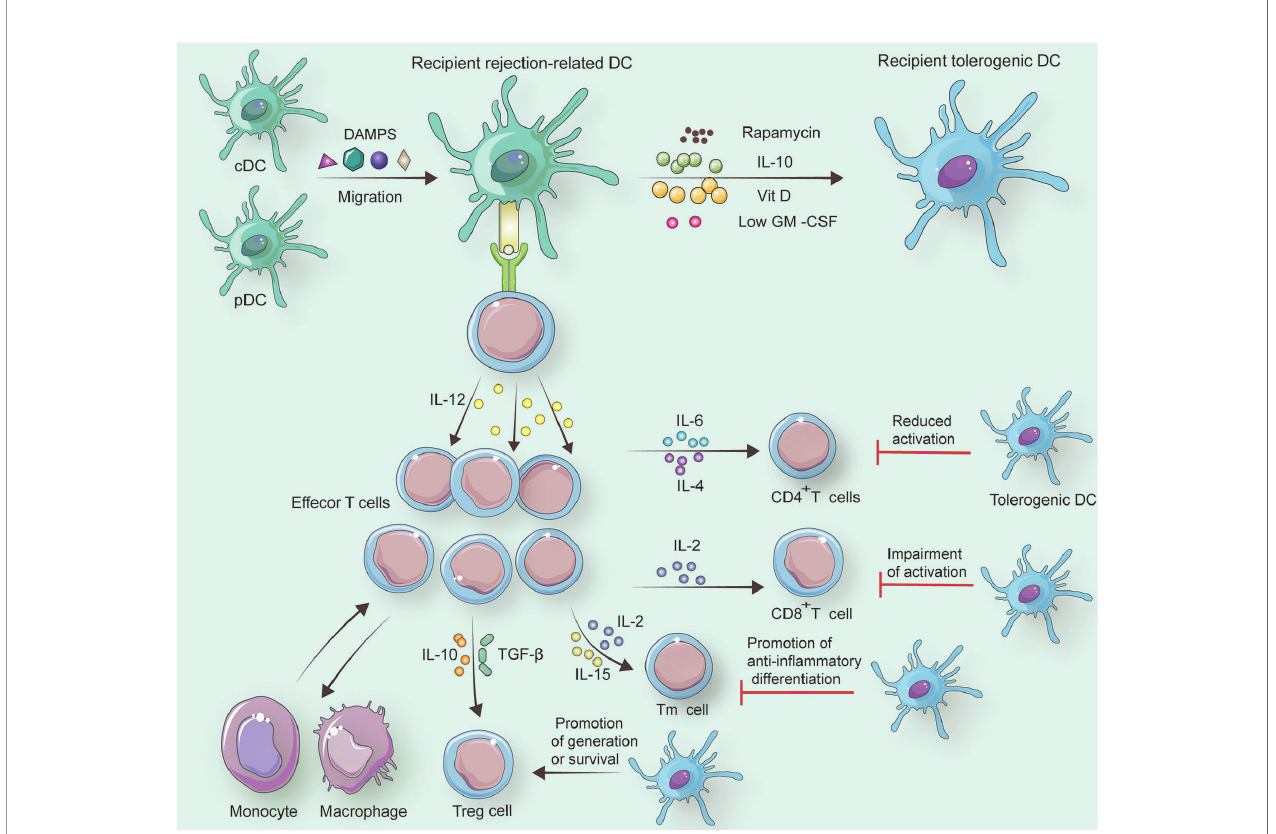
FIGURE 3 | In response to speci fi c factors including DAMPs, recipient cDCs and pDCs change into recipient rejection-related DCs. If rapamycin, IL-10, Vit D, or a low dose of GM-CSF is employed to treat recipient rejection-related DCs, recipient tolerogenic DCs can be generated. Under the control of recipient rejection-related DCs, naive T cells differentiate to CD8 + T cells with the help of IL-2 and differentiate to CD4 + T cells assisted by IL-6 and IL-4. Memory T cells (Tm cells) also originate from naïve T cells, and this alteration is associated with IL-2 and IL-15. Treg cells can occur when IL-10 and TGF- b are secreted by recipient rejection-related DCs. Besides, tolerogenic DCs reduce CD4 + T cell activation, and they can impair active CD8 + T cells. Furthermore, Tm cells tend to be anti-in fl ammatory promoted by tolerogenic DCs. Treg cells survive for a longer period with tolerogenic DCs than with rejection-related